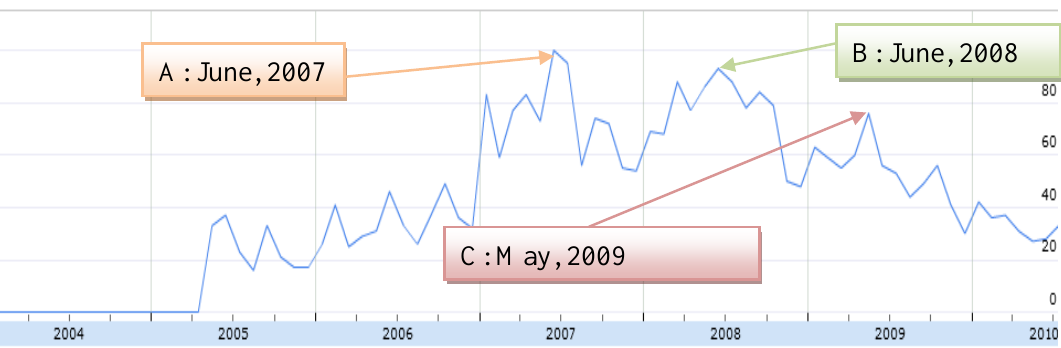
Figure 4. Index of interest shown in search term “Maibagu” ( Graph generated by Google Insights for Search on 19 July 2010 ).